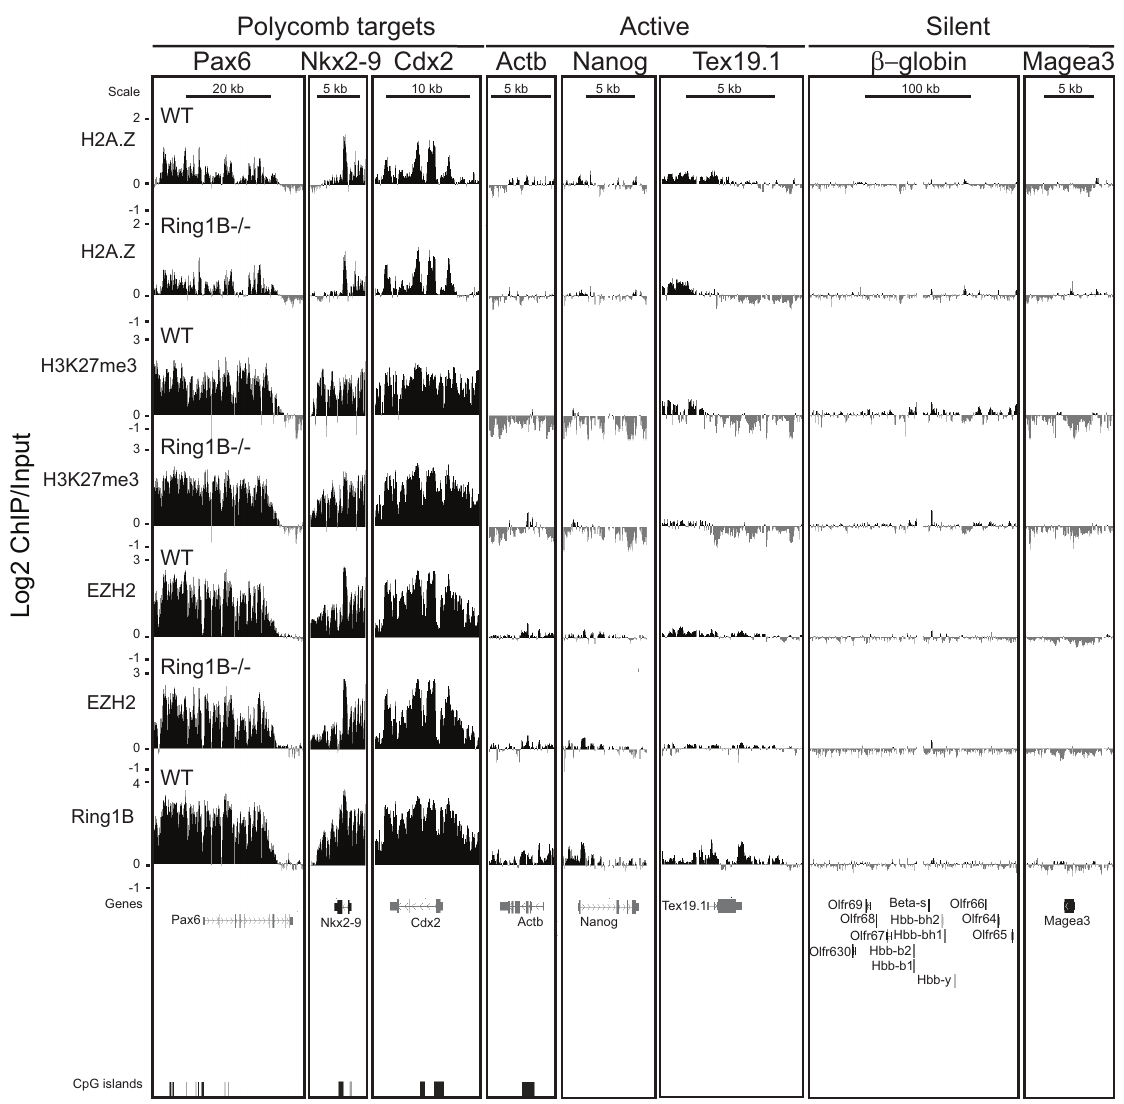
Figure 4. H2A.Z is enriched at developmental genes in wild-type and PRC1 mutant ESCs. Log2 of ChIP:input for: H2A.Z, H3K27me3, EZH2 and Ring1B from WT ( + / + ) (top) and Ring1B 2 / 2 (bottom) ESCs using a custom tiling microarray. Data is shown for selected polycomb target genes ( Pax6, Nkx2-9 and Cdx2 ), active genes ( Actb, Nanog and Tex19.1 ) and silent genes ( b -globin locus and Magea3 ). The data represent a mean of 2 biological replicates. RefSeq gene annotations and CGIs are from the July 2007 (mm9) Build 37 assembly of the mouse genome